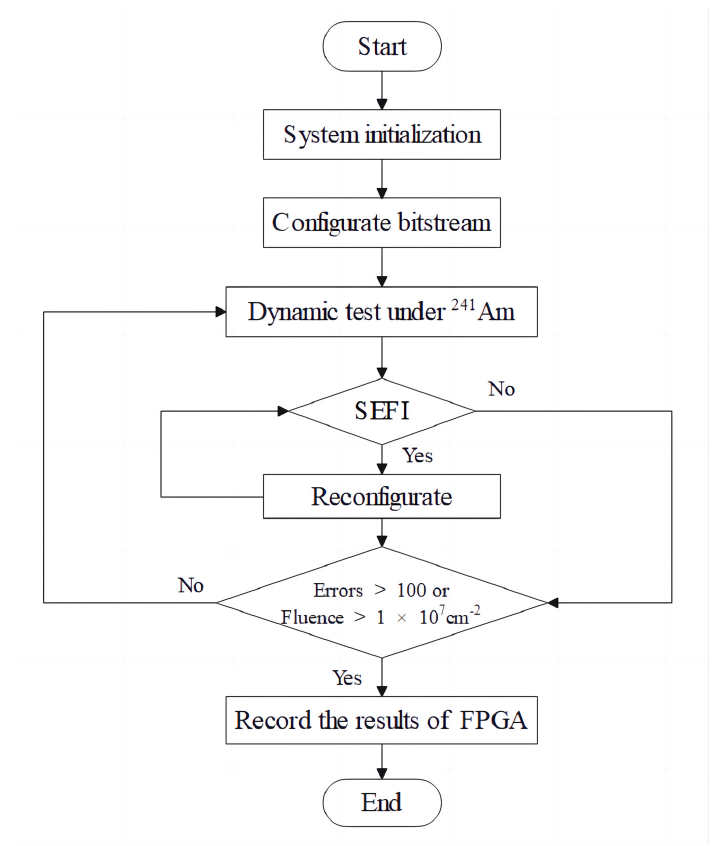
Figure 6. Single event effect dynamic test flow. Table 3. Various test conditions for different modules of the device under test.